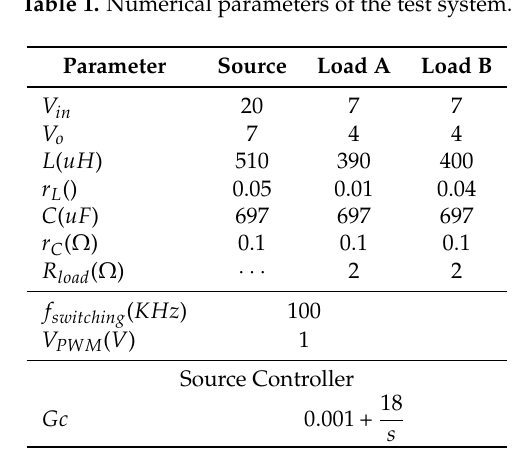
Figure 6. Experimental setup schematic diagram. Table 1. Numerical parameters of the test